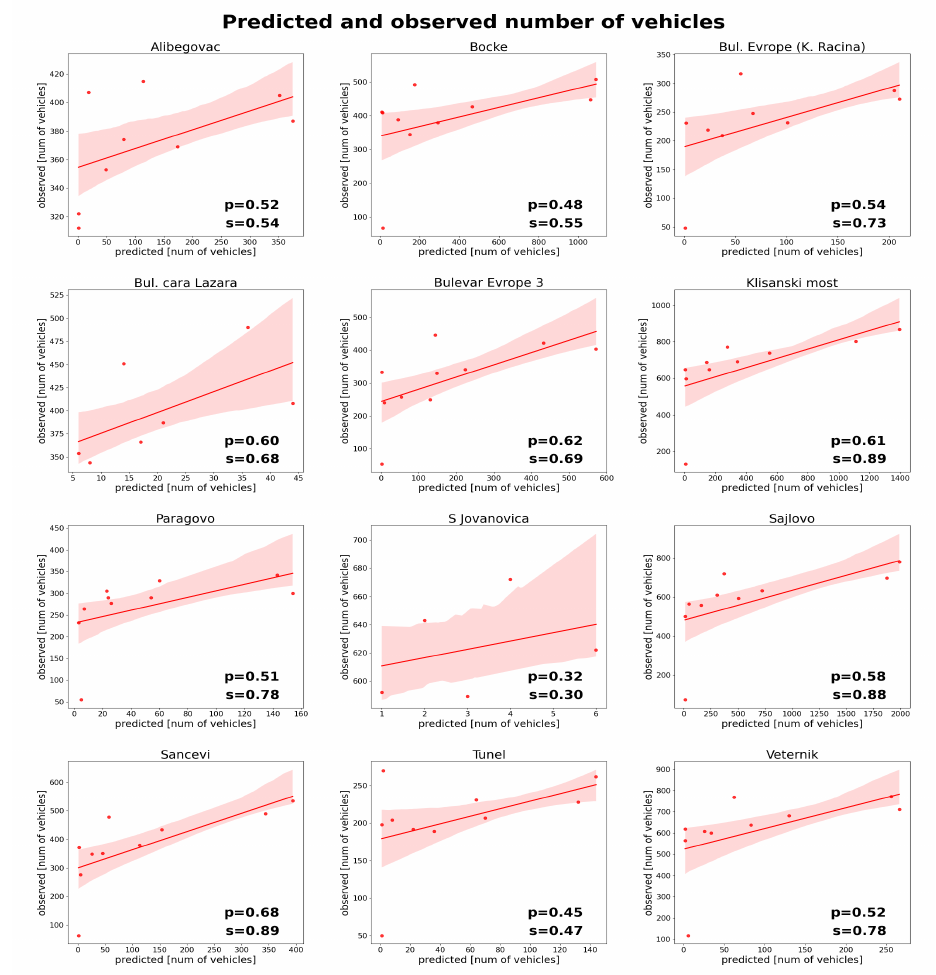
Figure A3. Validation—Pearson’s (p) and Spearman’s (s) correlation coefficients between predicted and observed number of cars in automatic vehicle counters data set. The selected day from automatic vehicle counters data set was 3 December 2019. Please note: the axes are not in the same scale to emphasize the captured